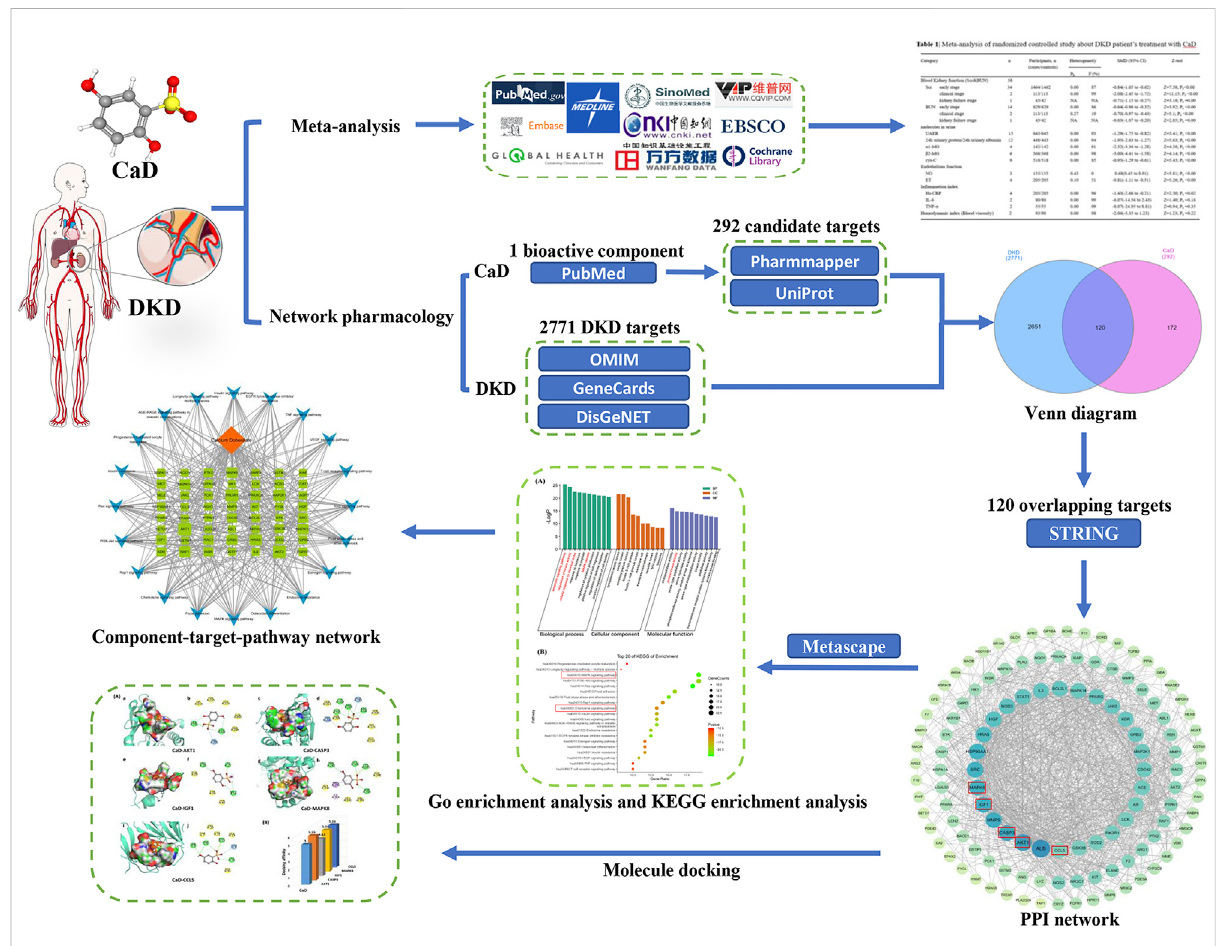
FIGURE 1 Flow chart of the investigation of calcium dobesilate in the treatment of diabetic kidney disease.